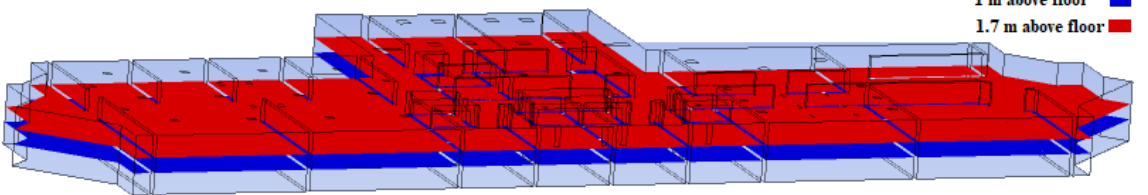
Figure 5. Results planes at 1 m and 1.7 m.